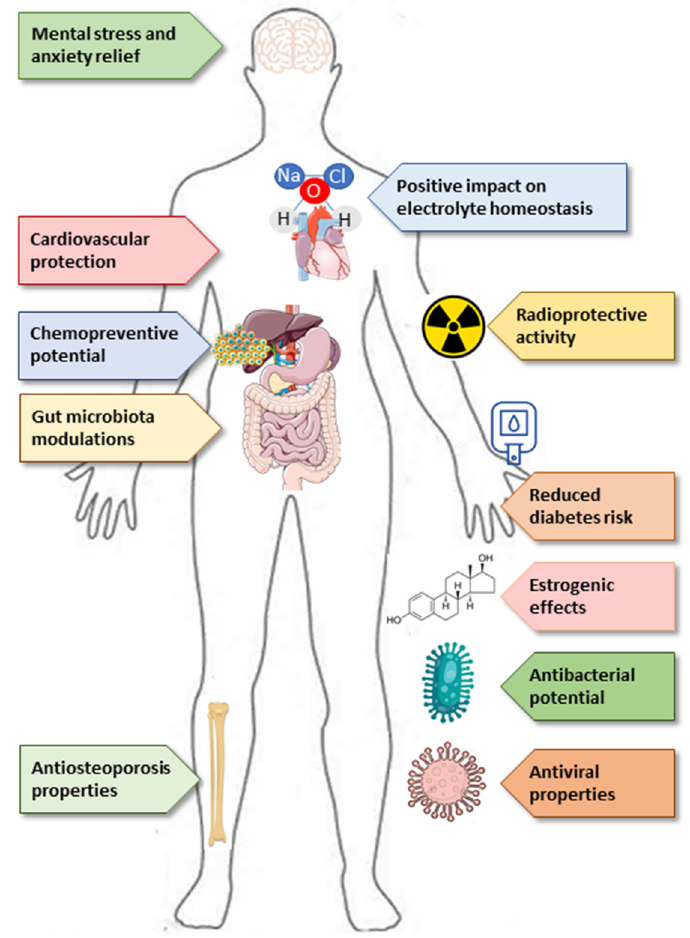
Figure 5. Potential properties of beer’s nonalcoholic fractions [13,51–61].